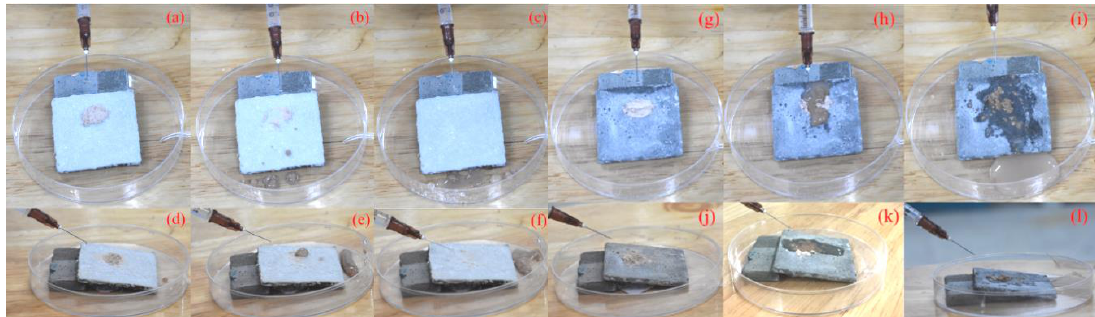
Figure 13. ( a – c ) The self-cleaning process on the SiO 2 aerosol @ DGEBA, ( d – f ): Side view of the self-cleaning process on the SiO 2 aerosol @ DGEBA, ( g – i ): The unsuccessful process of self-cleaning on the untreated cement surface, ( j – l ): Side view of the unsuccessful process of self-cleaning on the untreated cement surface.